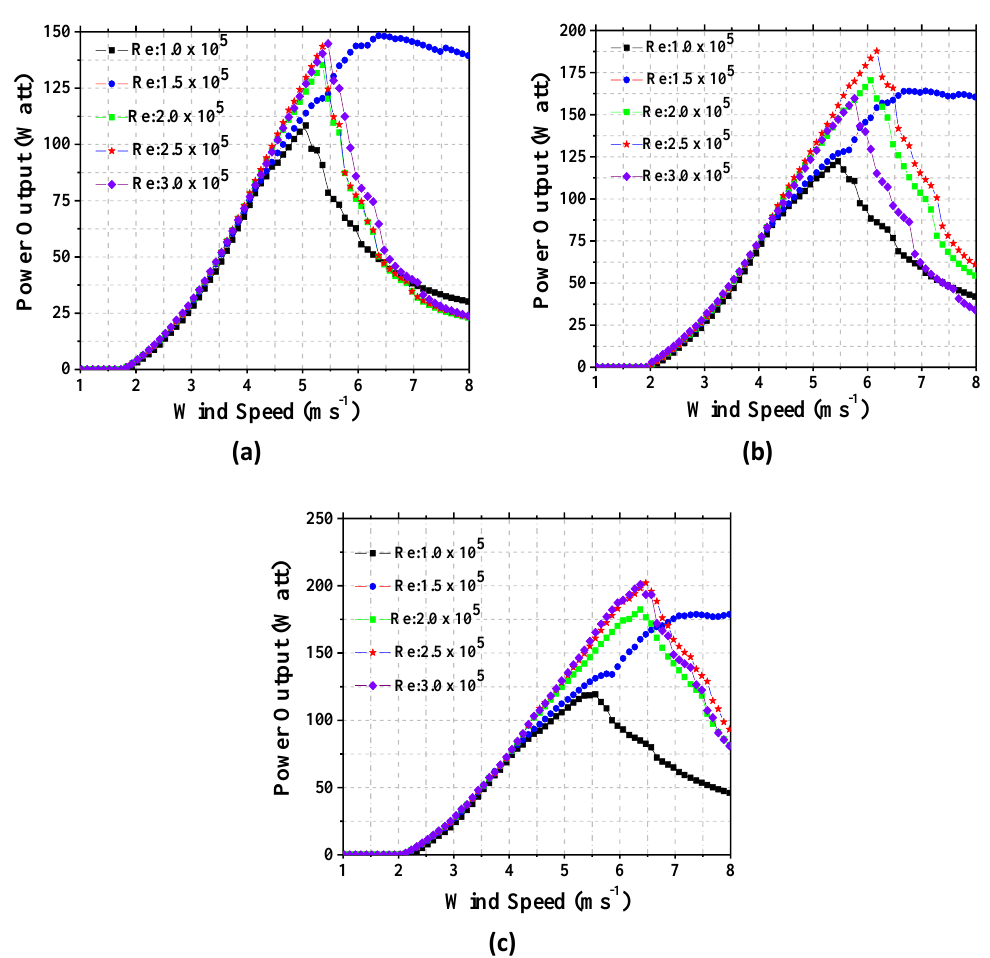
Figure 16. Power output for NACA 4412 at design ( a ) TSR 4; ( b ) TSR 5; ( c ) TSR 6.